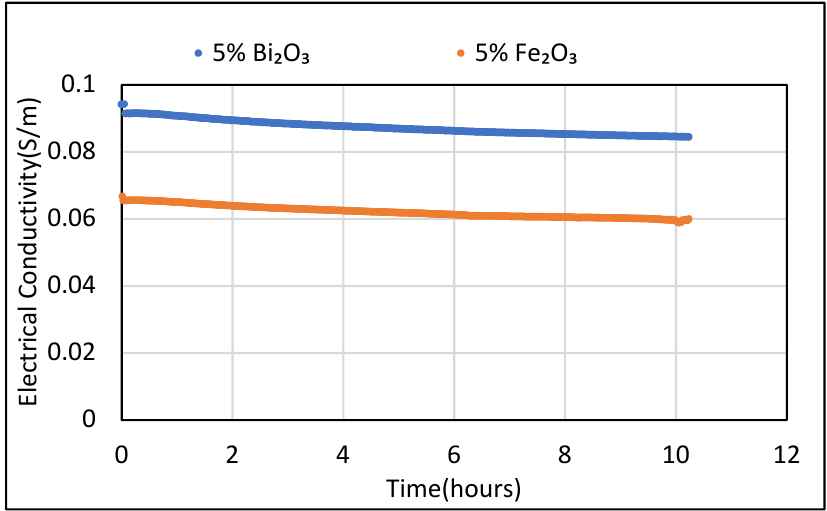
Figure 8. Electrical conductivity of cement composite with 5 wt.% Bi 2 O 3 and 5wt.% Fe 2 O 3 in saturated condition.